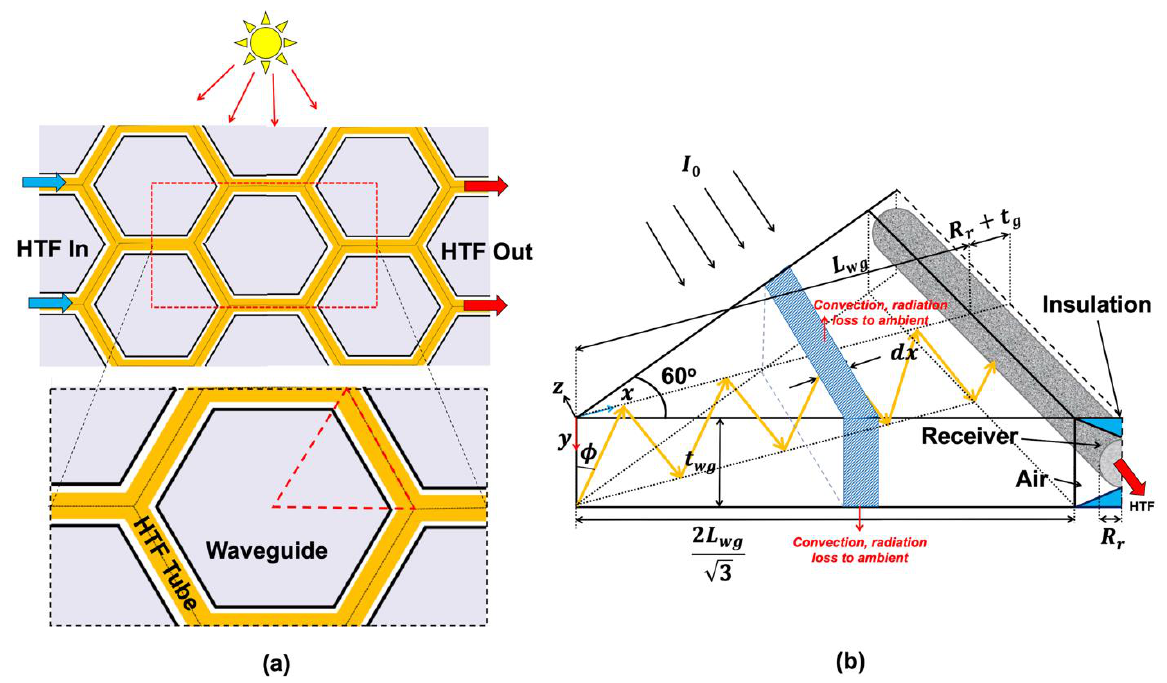
Figure 1. Schematic representation of: ( a ) top view of the hexagonal waveguide solar concentrator integrated with the receiver and ( b ) control volume depicting ray propagation and heat fluxes.